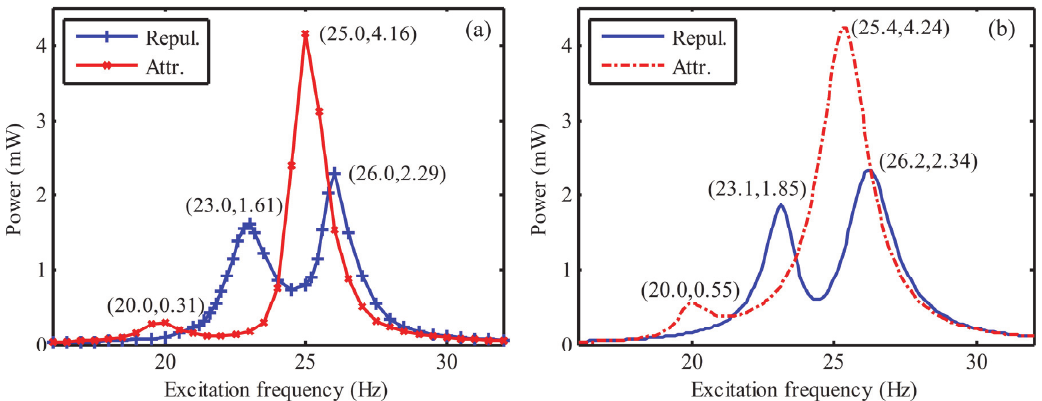
Figure 14. Frequency responses for the HEH with different directions of magnetic force: ( a ) experimental results; ( b ) numerical results.